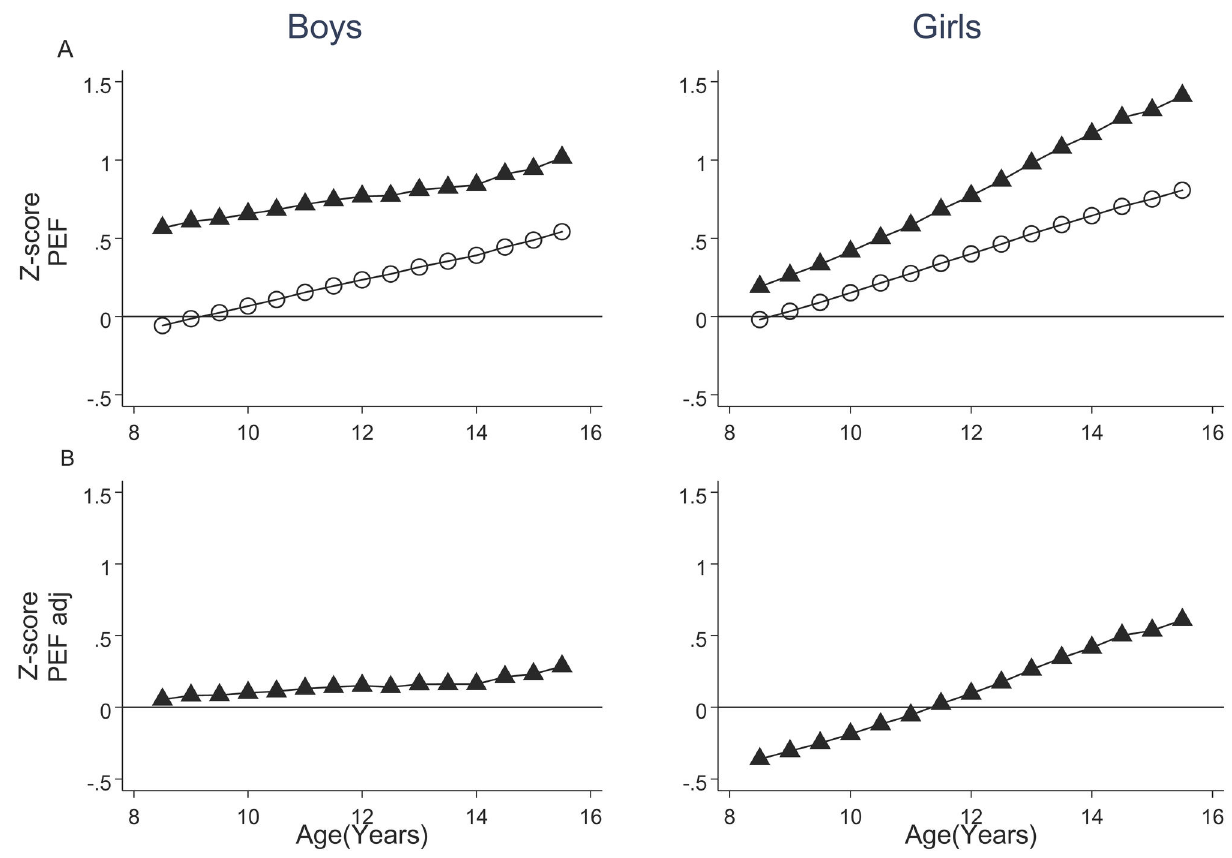
Figure 3. Peak expiratory flow (PEF) growth of a cohort of Mexican children compared with the National Health and Nutrition Examination Survey III (NHANES-III) equation. PEF of children in the cohort expressed as Z-score of the Mexican- American children from the NHANES III study (full triangles, panel A), and Mexican children from a cross-sectional study (empty circles, panel A). Panel B has PEF of Mexican children adjusted to that estimated at sea level. The majority of values for age-, gender- and height-adjusted PEF in Mexican children from the reported cohort are positive compared with those of children among Mexican-American children, and these in addition increase during growth relative to predicted values. Adjusting PEF in Mexico City to sea level values (see Supporting Information) partially reduces the positive bias especially in